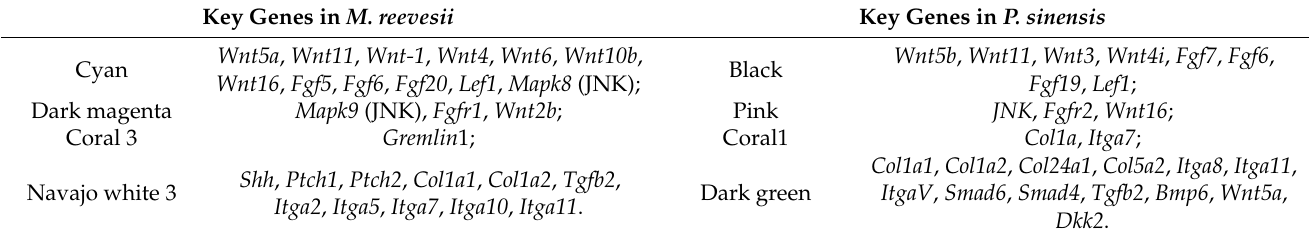
Table 3. Key genes of the high relationship gene modules of the CR samples of M . reevesii